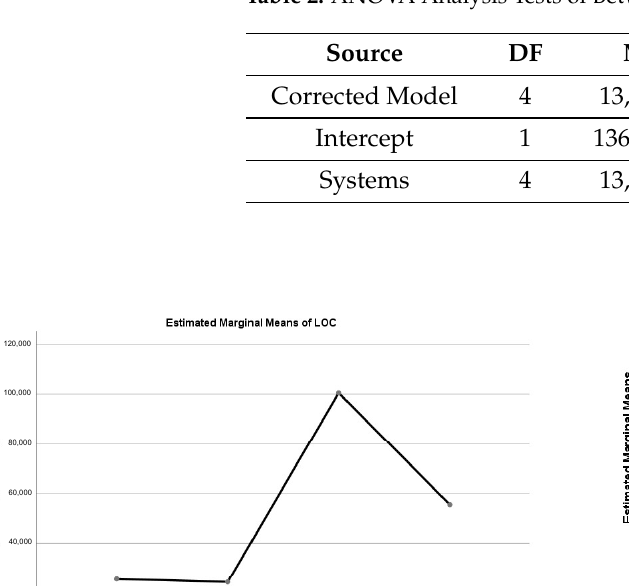
Figure 1. The change in the LOC as a function of the version. Table 2. ANOVA Analysis Tests of Between-Subjects Effects.